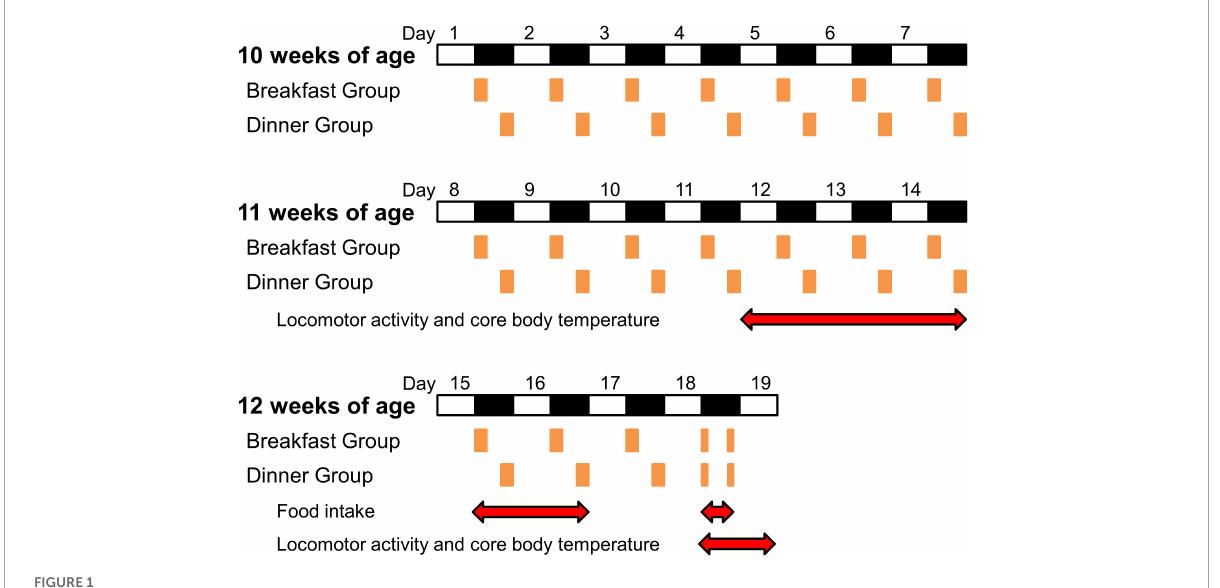
FIGURE1 Protocol for the experiments. White and black bars indicate light and dark periods, respectively. Orange boxes indicate feeding times. Red double-headed arrows show measurement periods for analysis.